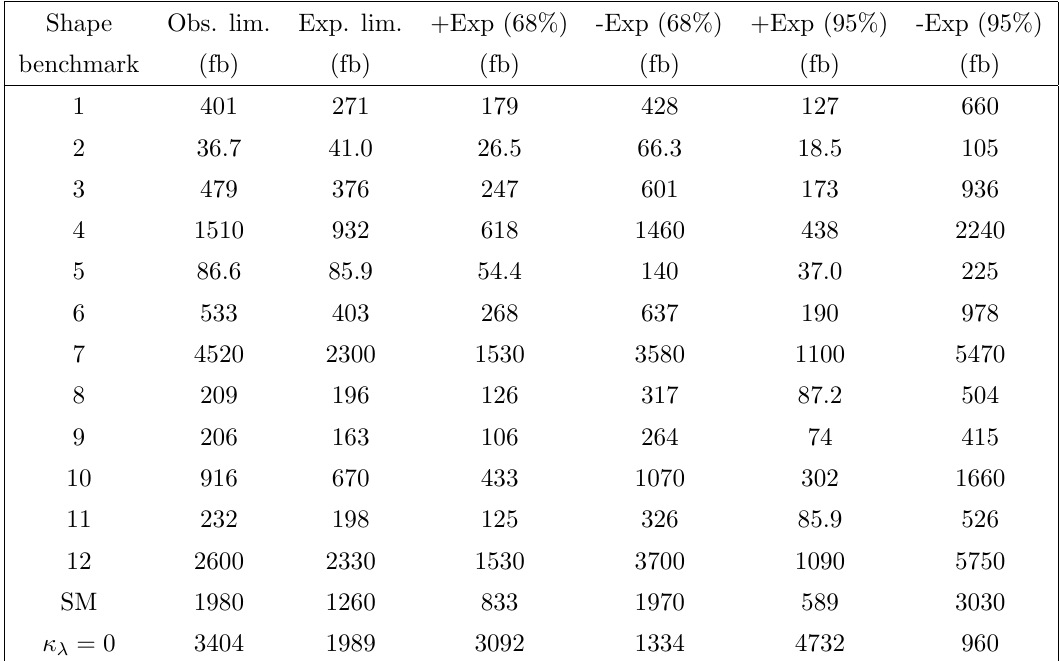
Table 6 . The observed and expected upper limits on the cross section (cid:27) (pp ! HH ! bbbb) for the non-resonant shape benchmark models (1{12), the SM, and the (cid:20) (cid:21) = 0 HH productions, combining fully-merged and semi-resolved channels (where the events used in the fully-merged analysis are not considered in the semi-resolved